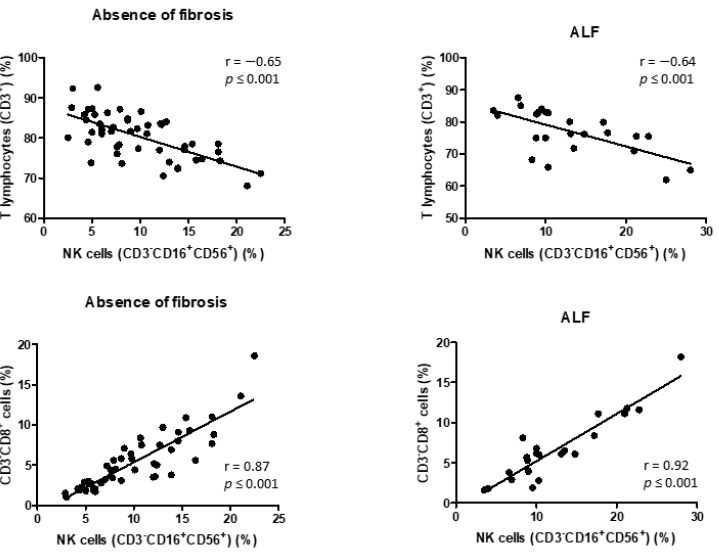
Figure 4. Correlations between proportion of NK cells, T cells, and CD3 - CD8 + cells according to degree of liver fibrosis (LF).